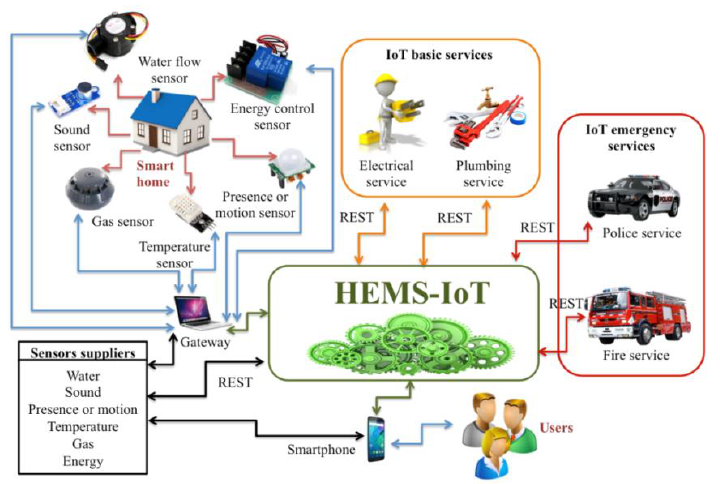
Figure 6. Scenario: Monitoring a smart house.